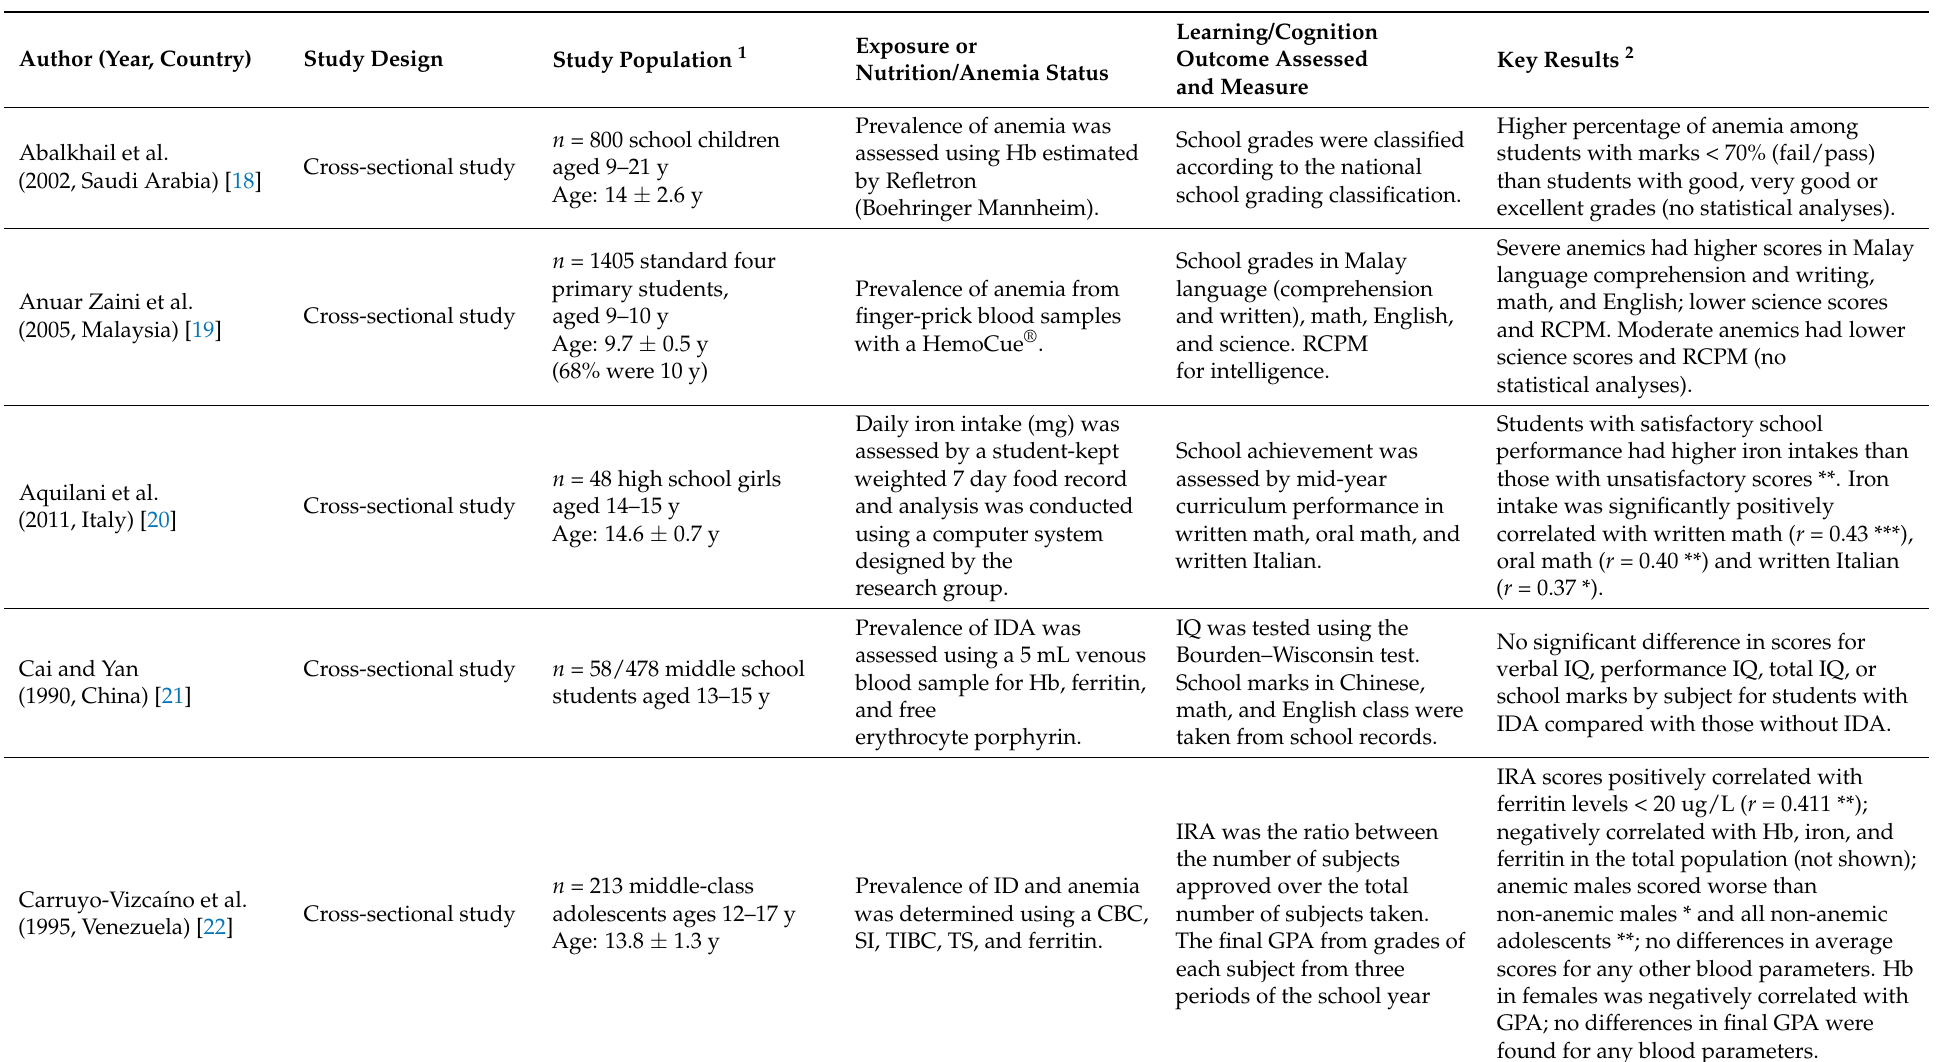
Table 1. Description and results of cross-sectional studies examining iron status or anemia and dimensions of academic performance and cognitive